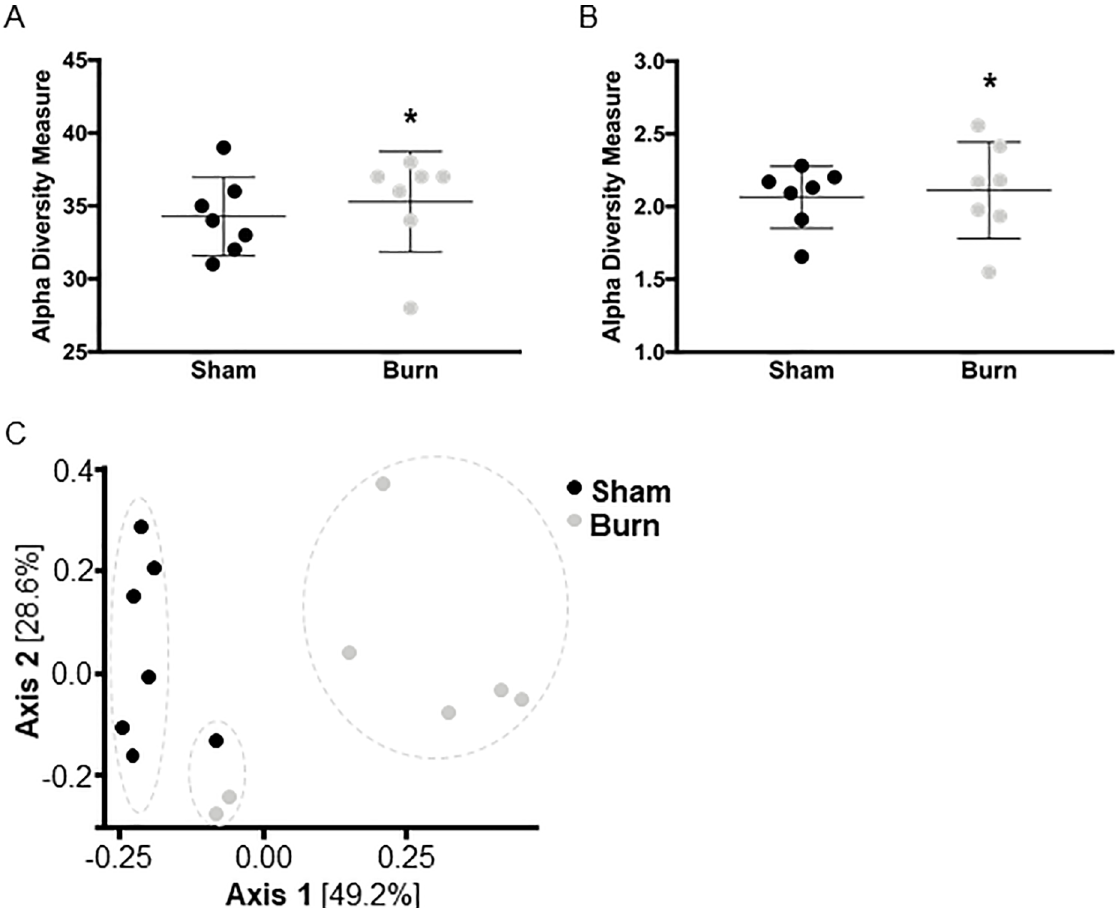
Fig 2. Microbiome structure upon burn injury. The richness ( A ) and Shannon index ( B ) of fecal samples collected from the cecum were used to estimate the level of diversity of the gut microbiome after burn injury (data shown as mean ± SD). Beta diversity was assessed by dimensional reduction of the Bray-Curtis distance between the microbiome samples, using the PCoA ordination method ( C ). For all experiments, each replicate is plotted (n = 7 mice/group), as well as mean ± SD. Asterisks indicate significant differences as assessed by Kruskal-Wallis rank sum